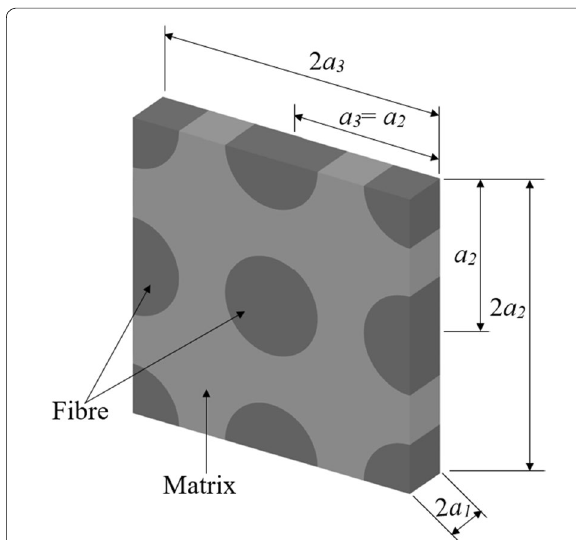
Fig. 2 The periodic microstructure model of a fibre reinforced